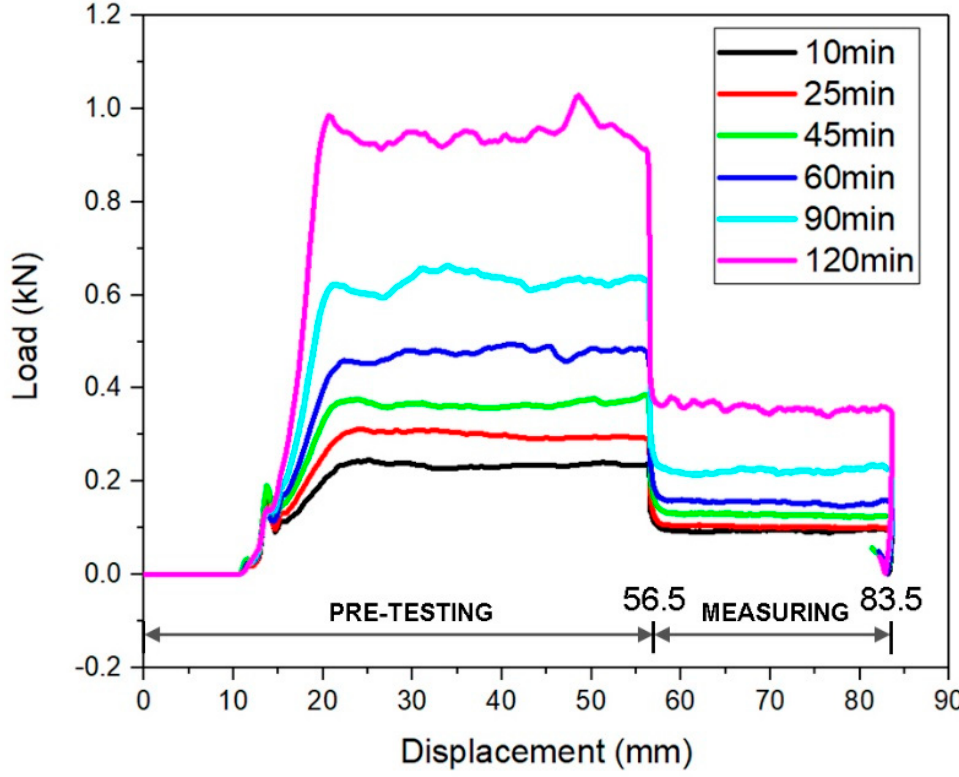
Figure 7. A typical plot of the test—extrusion pressures with different ages (MIX-2).